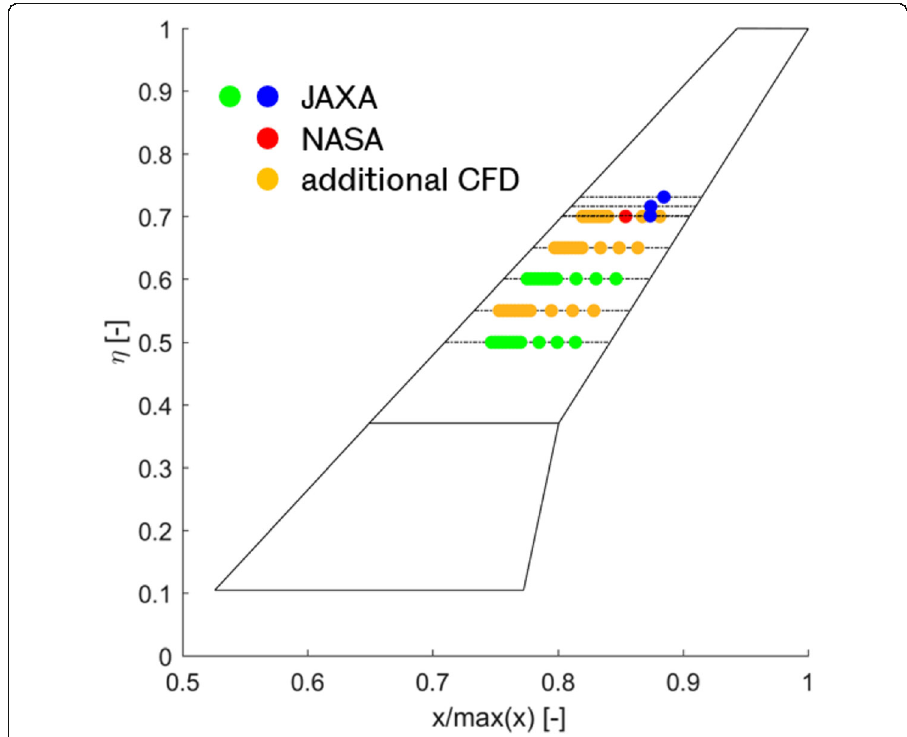
Fig. 6 Location of C P probes on the upper surface of the wing based on experiments from JAXA [18, 24] and NASA [30] plus additional ones included in CFD